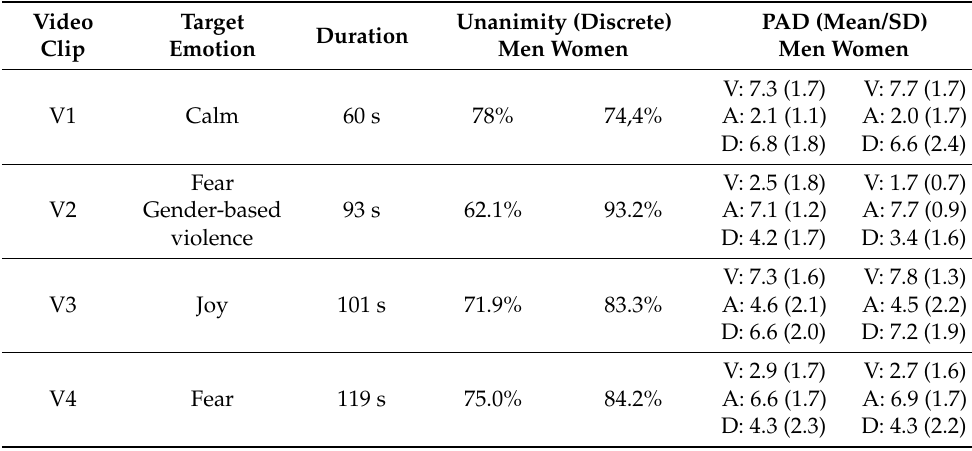
Table 3. Emotional Labelling of the video clips used in the experiment [28].